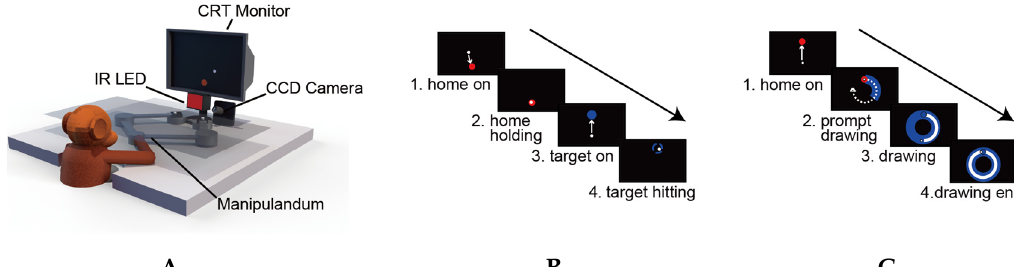
Figure 1. Experimental setup and time consequence of the tasks are illustrated. ( A ) A monkey directs a cursor on a monitor by manipulating a robotic arm with its right hand on a horizontal plane. The hand position and its eye position are recorded during the tasks. ( B ) Hitting task: monkeys are required to move the cursor from the bottom red home point to the top blue target point within a designated amount of time. ( C ) Circle drawing task: a prompt shows the required direction (blue: